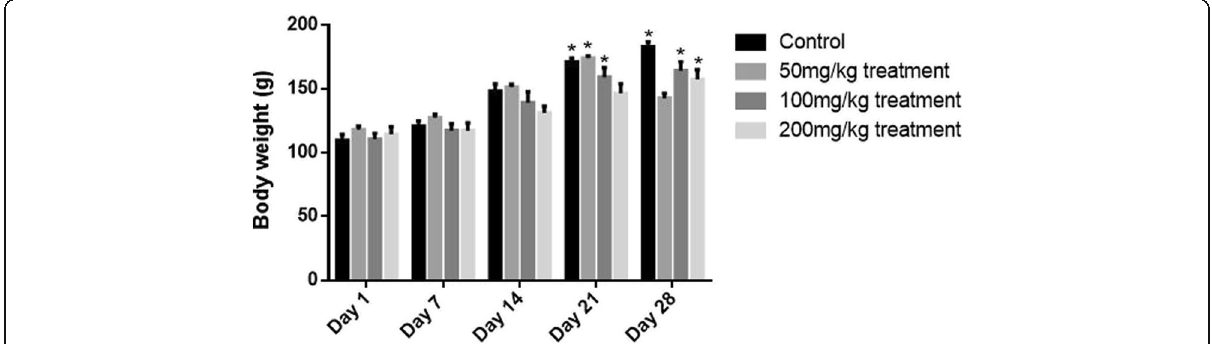
Fig. 2 Body weight variation of control and treated female rats during sub-acute toxicity studies. The data is presented as mean ± SEM. Two-way ANOVA was used for multiple comparisons by applying Dunnett's test and the weights of all the groups were compared with their relevant weight on Day 1. * represents significance of p <